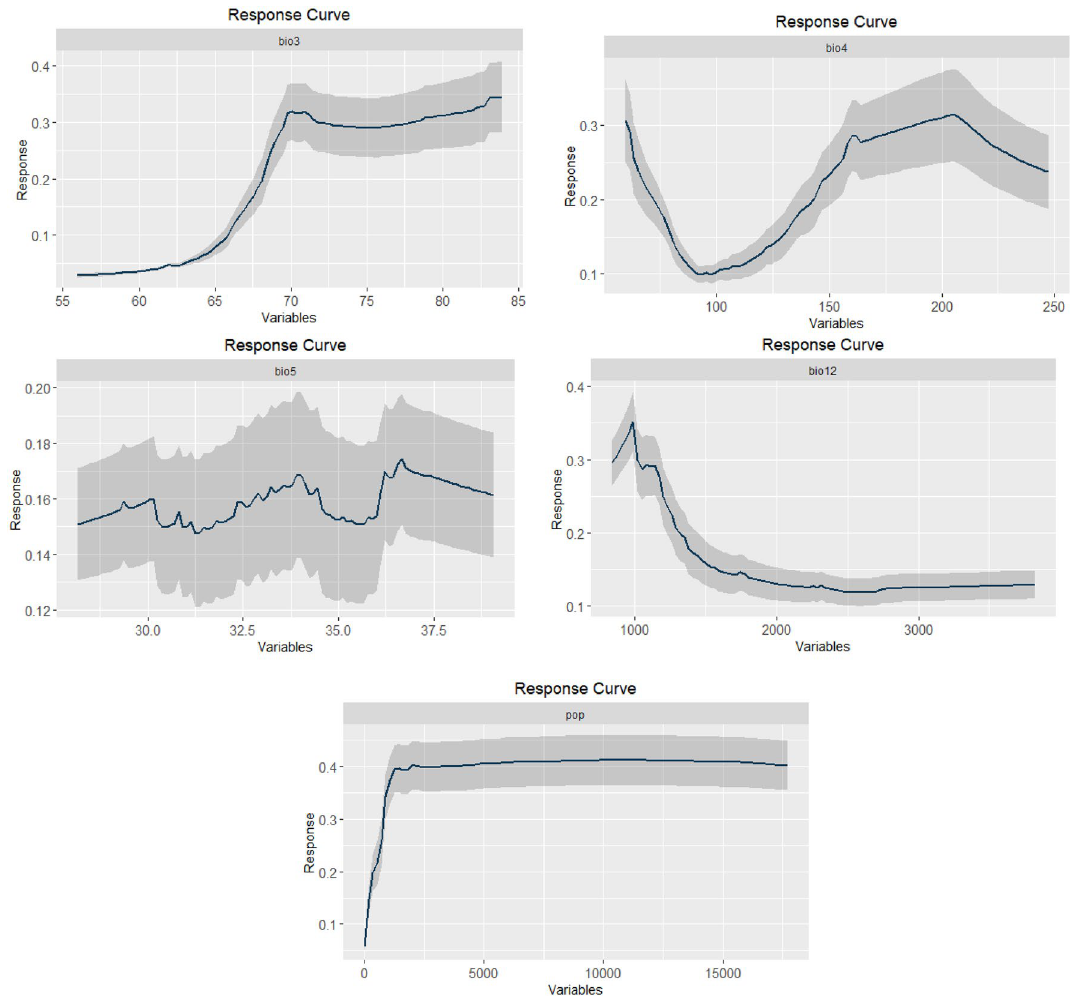
Figure 3. Response curves of the environmental variables retained in Machine learning models (Maxent, BRT, and RF) (the curves were generated using R version 4.1.3 (https:// www.R- proje ct. org/)).